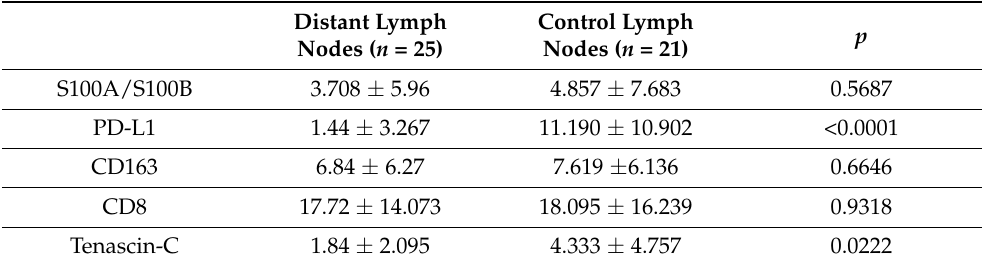
Table 3. Comparison between distant cancer-draining lymph nodes and non-cancer-draining lymph nodes.